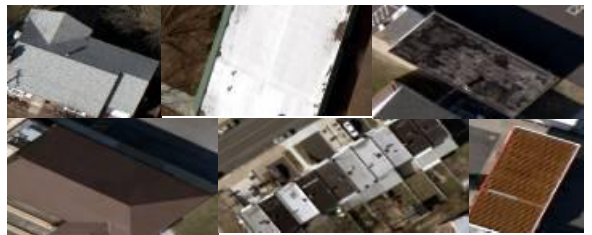
Figure 1. Six different building colors and patterns from one image with a GSD 0.14′: a supervised building region growing classification would need six signatures. Two (upper-right and lower-middle) cannot be used because they are